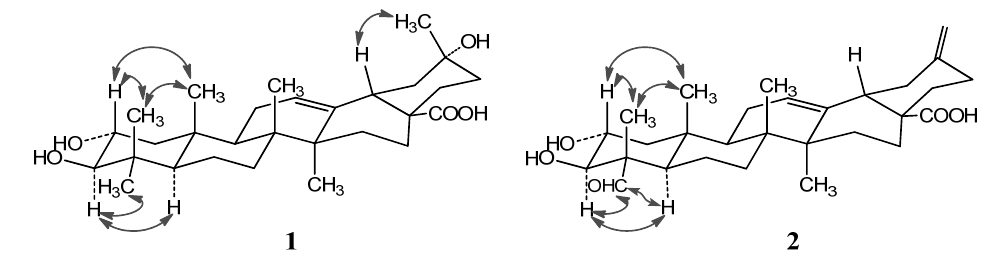
Figure 2. Important NOESY correlations of compounds 1 and 2 .